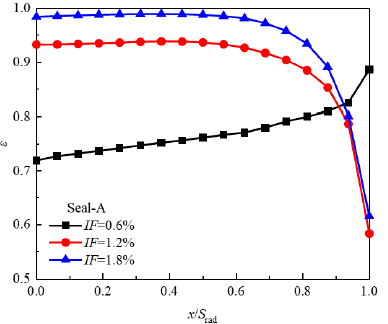
Figure 16. Time-averaged sealing efficiency variations along the axial direction at the middle section of the sealing cavity.